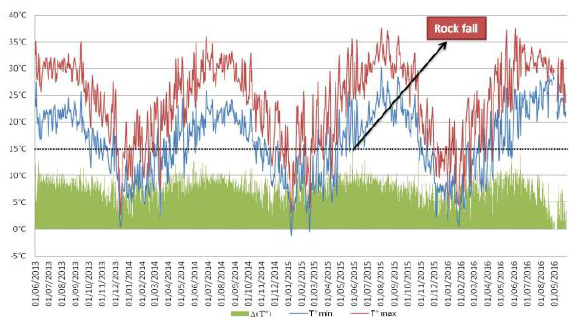
Figure 7. Trend of air temperature in the 'Siq' of Petra from June 2013 to October 2016.